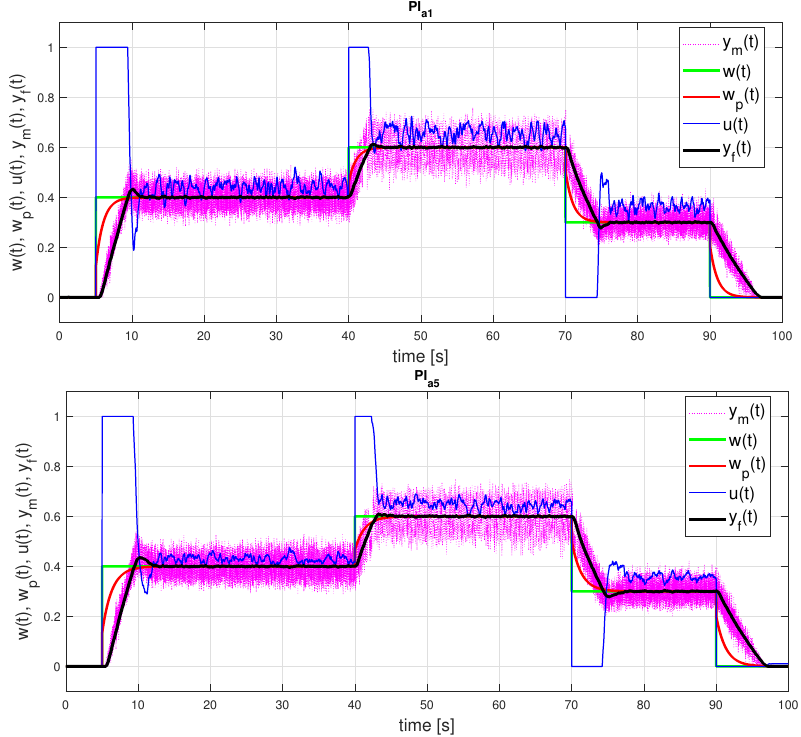
Figure 7. PI control: setpoint responses corresponding to FOTD approximations of an initial part of a normed step response y n ( t ) for t a ≤ 1 (42) with the parameters (44) (above) and for t a ≤ 5 (43) with the parameters (45)